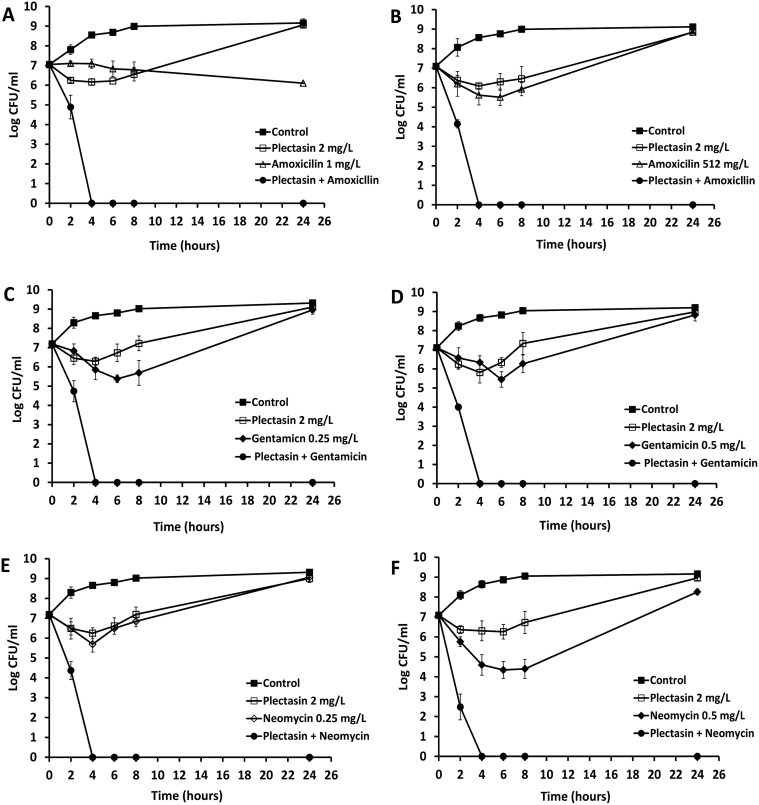
Time-kill analysis showing the effects of plectation in combination with amoxicillin, gentamicin and neomycin against log phase MSSA and MRSA.The peptide and antibiotics alone or each combined with plectasin were added to the log-phase cultures and CFU counts were carried out at different time points. Combination of plectasin (2 mg/L) and amoxicillin (1 mg/L or 512 mg/L) against MSSA (A) and MRSA (B). Combination of plectasin (2 mg/L) and gentamicin (0.25 and 0.5 mg/L) against MRSA (C) and MRSA (D). Combination of plectasin (2 mg/L) and neomycin (0.25 and 0.5 mg/L) against MSSA (E) and MRSA (F). Results shown are the mean of three independent experiments.